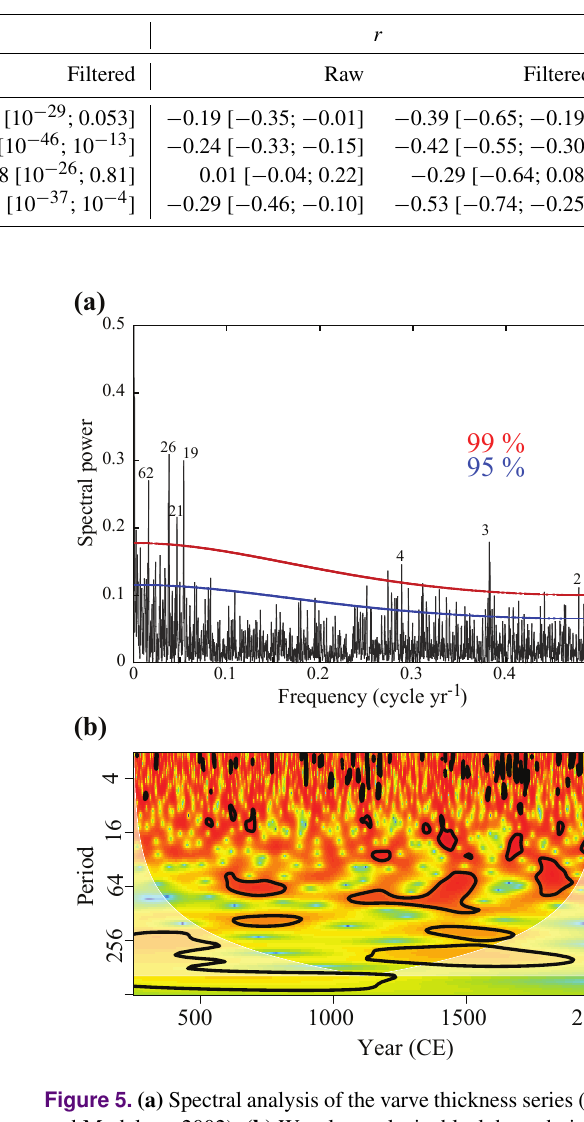
Table 1. Correlation analysis for the varve thickness at Cape Bounty East Lake and different proxy records of PDO. r is Pearson’s correlation coefficient, and p is the probability that two uncorrelated time series would exhibit a higher correlation. The percentile confidence intervals at 95%, calculated from 1000 non-parametric stationary bootstrap iterations, are indicated in brackets.